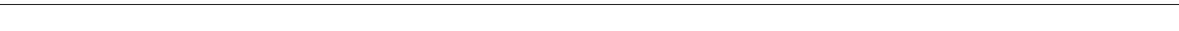
Fig. 1 Lung DCs are required for eosinophil recruitment during allergen challenge. a Mice model of kinetics of eosinophil recruitment. b , c FACS ( b ) and total numbers ( c ) of eosinophil recruitment in different lung compartments in the murine kinetics model of allergic in fl ammation shown in a . Upper row, lung tissue homogenates; lower row, Balf. n = 4 – 8 mice per group. d Protocol for in vivo recruitment assay (air-pouch assay). e Counts of eosinophils recruited into the air pouches of wild-type (WT) mice injected with lung CD45 − cells or CD45 + cells (left), lung CD4 + T cells (middle), or ILC2s (right) were analyzed by FACS. n = 5 – 7 mice per group. f – h Eosinophil recruitment of allergic CD11c-DTR Tg (empty circle) or WT (solid circle) mice i.t. injected with DT to delete lung CD11c + DCs and AMs, where f shows the protocol. g Different deletion ef fi ciencies of DCs and AMs in the lung of CD11c-DTR Tg or WT mice after i.t. instillation with DT. h Total numbers of eosinophils in the lung or Balf. n = 4 mice (Saline) or n = 6 mice (OVA). i – k Eosinophil recruitment of allergic C57Bl/6 mice i.t. injected with clodronate liposome (CLL) (empty circle) or control (solid circle) on day − 1.5 to delete lung